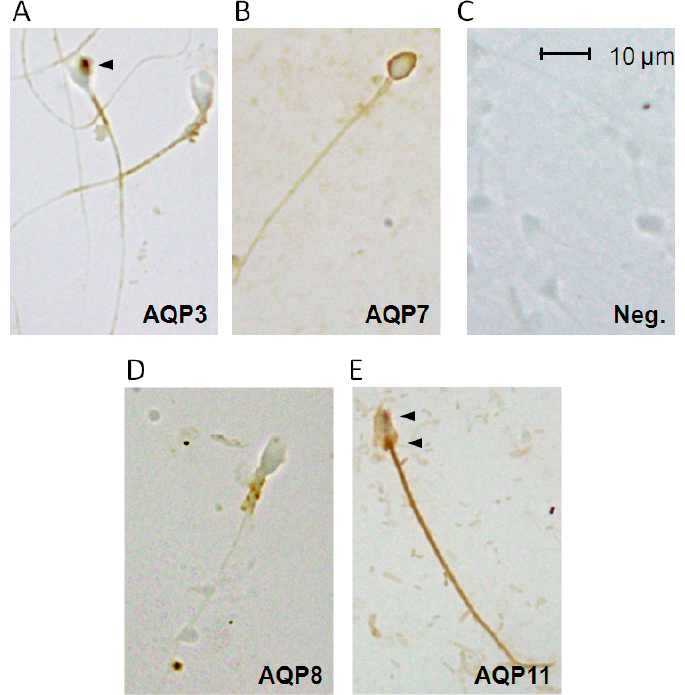
Figure 2. Immunocytochemical localization of the AQP3, -7, -8 and -11 proteins in human ejaculated semen from normospermic subjects: ( A ) AQP3 immunoreactivity was observed in the principal piece of the sperm tail membrane and in 3% of sperms in granules present in the head and in the midpiece (arrowhead); ( B ) intense AQP7 staining was observed in the plasma membrane region of the sperm head; ( D ) AQP8 labeled the midpiece of the spermatozoa, apparently in the mitochondria; and ( E ) AQP11 protein was localized into granules and vesicles of soma (arrowheads) and in the tail. Controls in which the primary antibody was substituted with non-immune serum show an absence of labeling (Neg.; ( C )). Scale bar, 10 μ m.